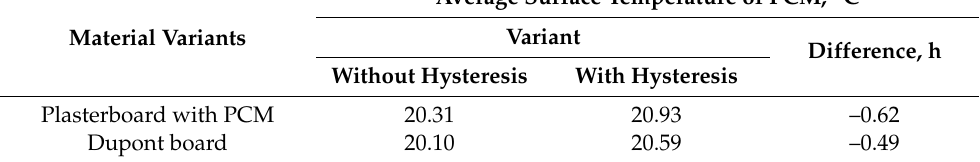
Table 3. Average surface temperature of materials for individual material variants and calculation variants.